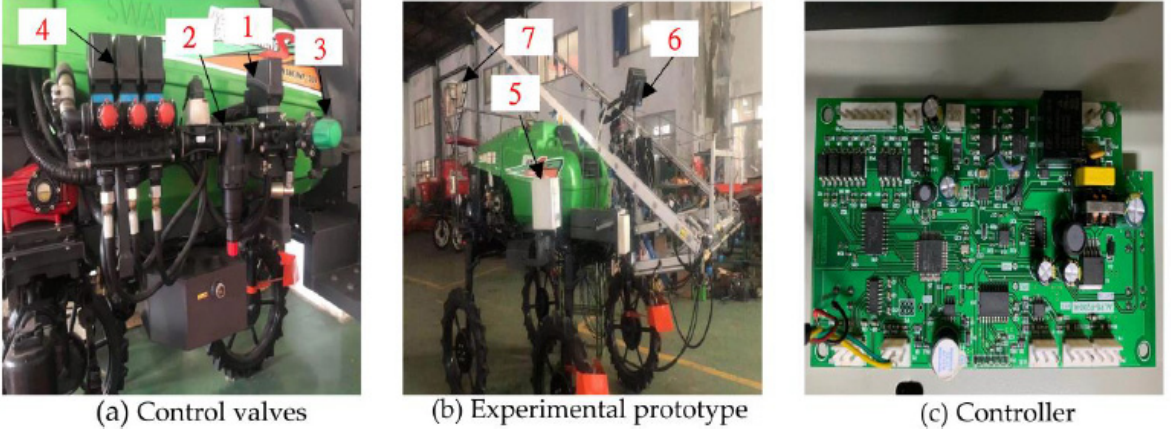
Figure 3. Field experiment prototype: 1, flow valve; 2, filter; 3, relief valve; 4, partition valve; 5, controller box; 6, computer; 7, GPS speed sensor.